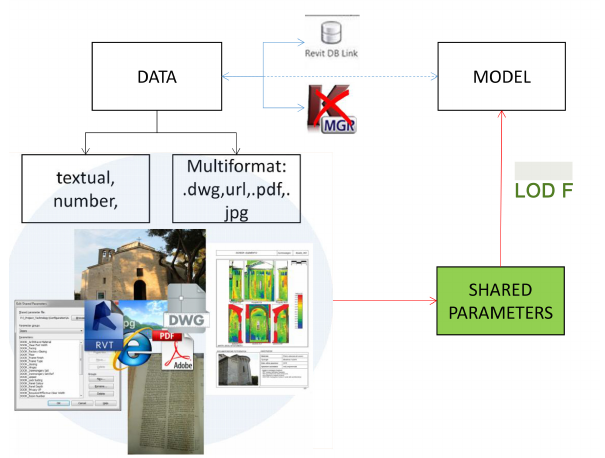
Figure 6. Data enrichment phase based on shared paramenters.